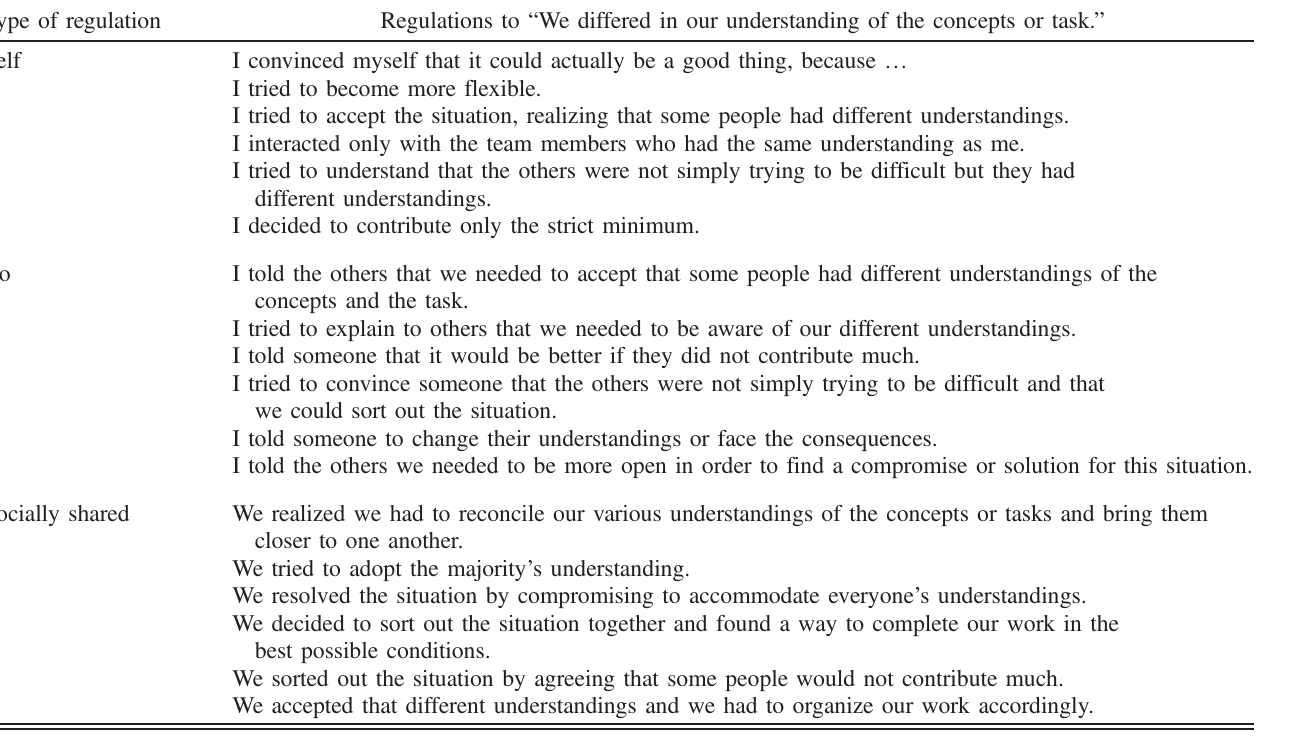
TABLE VI. Example of regulations to the teamwork challenge “ we differed in our understanding of the concepts or task ” from the AIRE survey. Each regulation is categorized into SRL, CoRL, and SSRL — six in each category. Type of